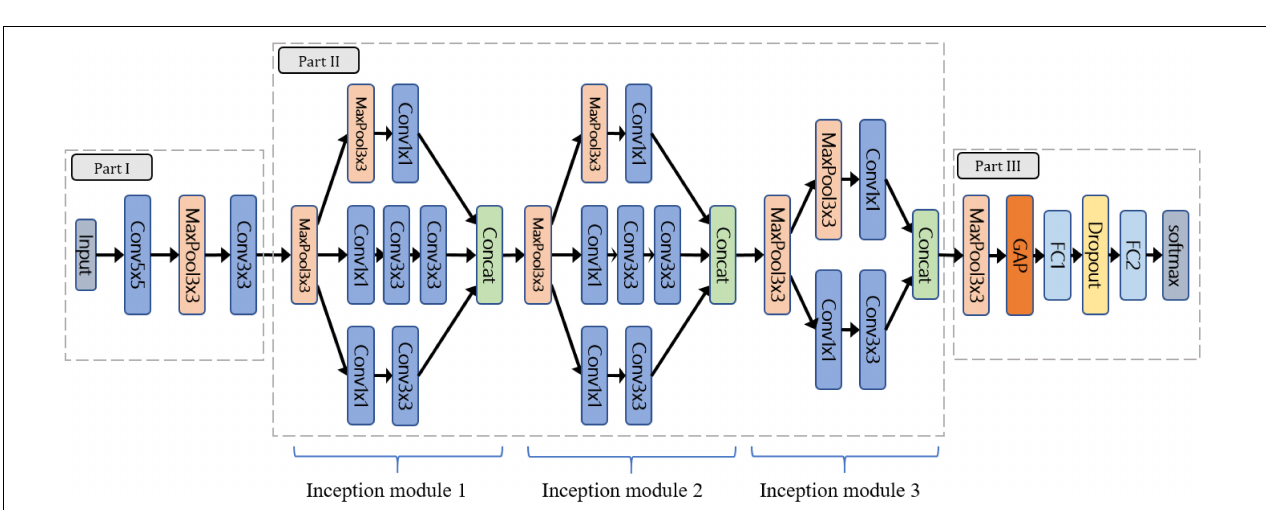
FIGURE 5 | An illustration of leaf region extraction and spectral reflectance generalization of plant species.